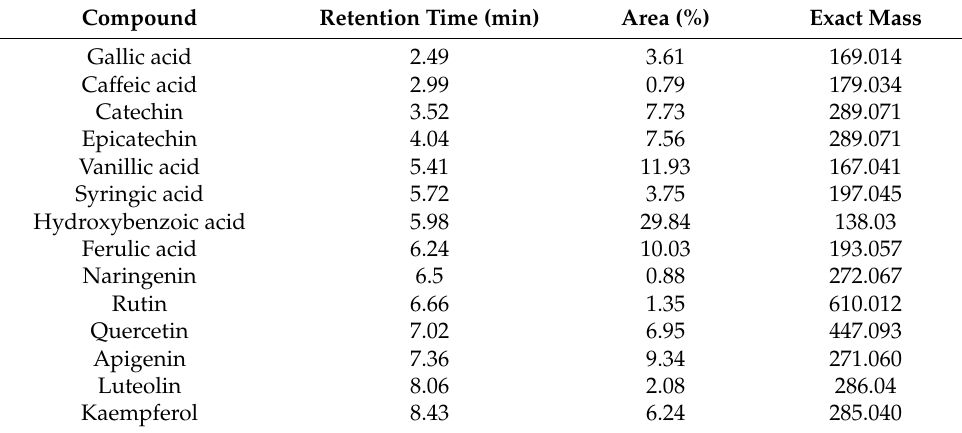
Figure 17. LC–Orbitrap-MS of Coriolus versicolor. Table 2. LC–Orbitrap-MS analysis of Coriolus Versicolor.